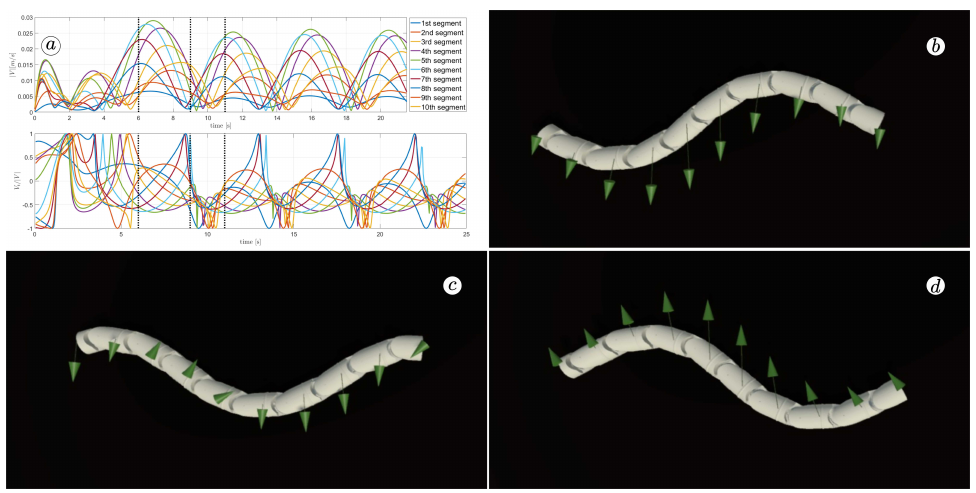
Figure 20. Absolute value and tangential component of segments velocities for c t = 10 and c n = 1 ( a ) and velocity vectors for t = 6 ( s ) ( b ), t = 9 ( s ) ( c ), and t = 11 ( s ) ( d ).